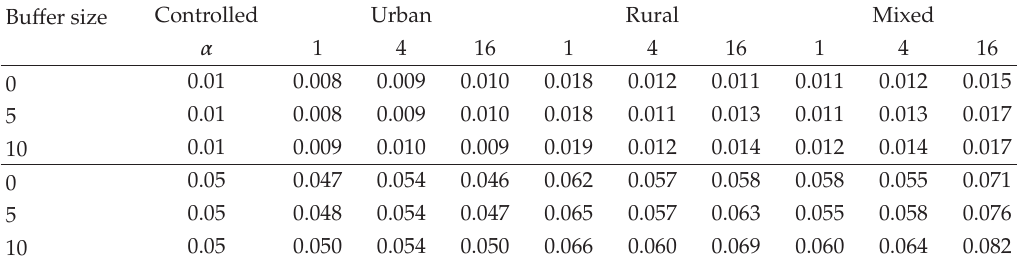
Table 3: Estimated type I error probabilities when testing the second most likely cluster when there is only one true cluster present, using the most likely cluster repalcement method. The bu ff er size is the number of neighboring counties. The true cluster consisting of 1, 4 or 16 counties is located in an urban, rural or mixed population area respectively, as described in the